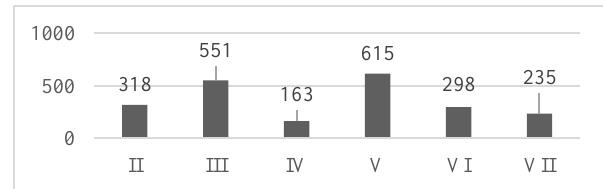
Figure 10 . Number of people getting an answer from troubleshooter per weekly